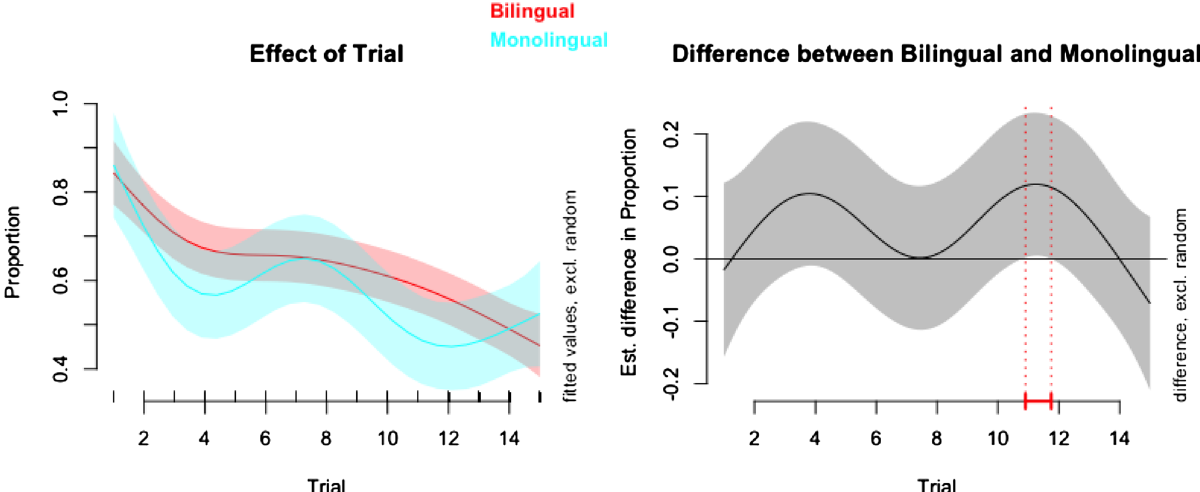
Figure 2. Fine grained analyses of the smooth terms in the generalized additive mixed model reveal that the estimated difference between bilinguals and monolinguals in number of switches per s (proportion of switches to time spent looking at the stimuli) is statistically significant ( p < 0.05) around Trial